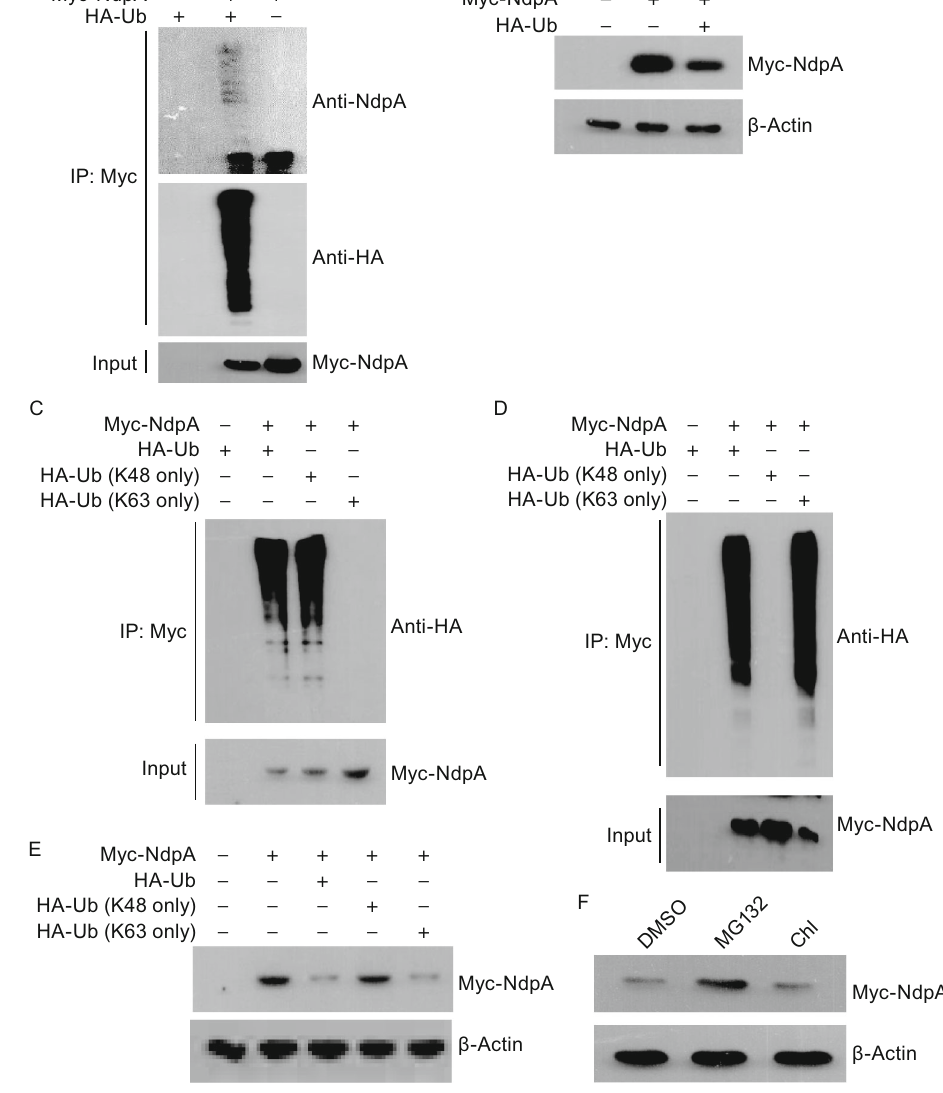
were constructed, including NdpA (K15A), NdpA (R16A), inhibitory effects of NdpA on ERK pathway (Fig. S4D). His-